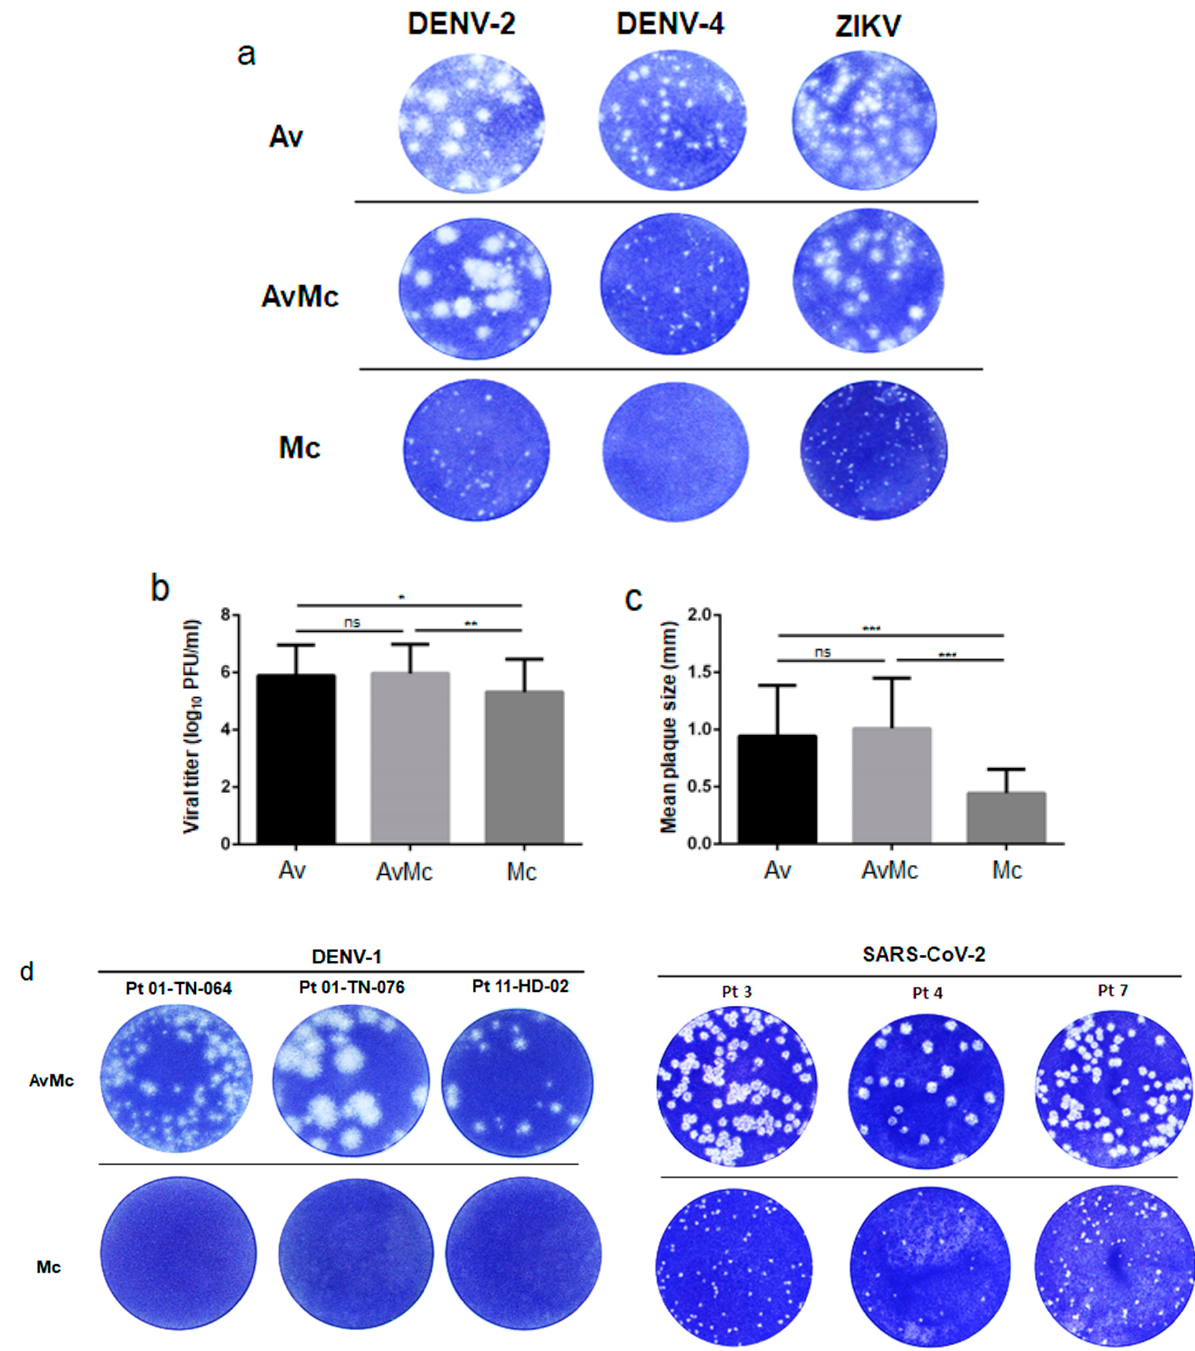
Figure 1. Virus titers of laboratory flavivirus strains and clinical DENV-1 and SARS-CoV-2 as determined using plaque assay. ( a ) Laboratory-established DENV-2, DENV-4, and ZIKV strains were diluted from 1:10 to 1:10 6 and inoculated onto Vero cell monolayer in 12-well plates. Plaque formation differed significantly by number ( b ) and size ( c ) at the same dilution for each virus between Avicel medium (Av) and methylcellulose (Mc). ( d ) Infectious virus titers of six clinical samples obtained from DENV-1 and SARS-CoV-2 patients were determined using Avicel-methylcellulose medium (AvMc) and methylcellulose medium (Mc). The mean of the DENV plaque size for each overlay media (mean ± SD). Each bar shows the mean value, and the error bar represents standard deviation. Significance was determined by unpaired Student’s t test, ns indicates “not significant”, * p < 0.05, ** p < 0.01 and *** p < 0.001.